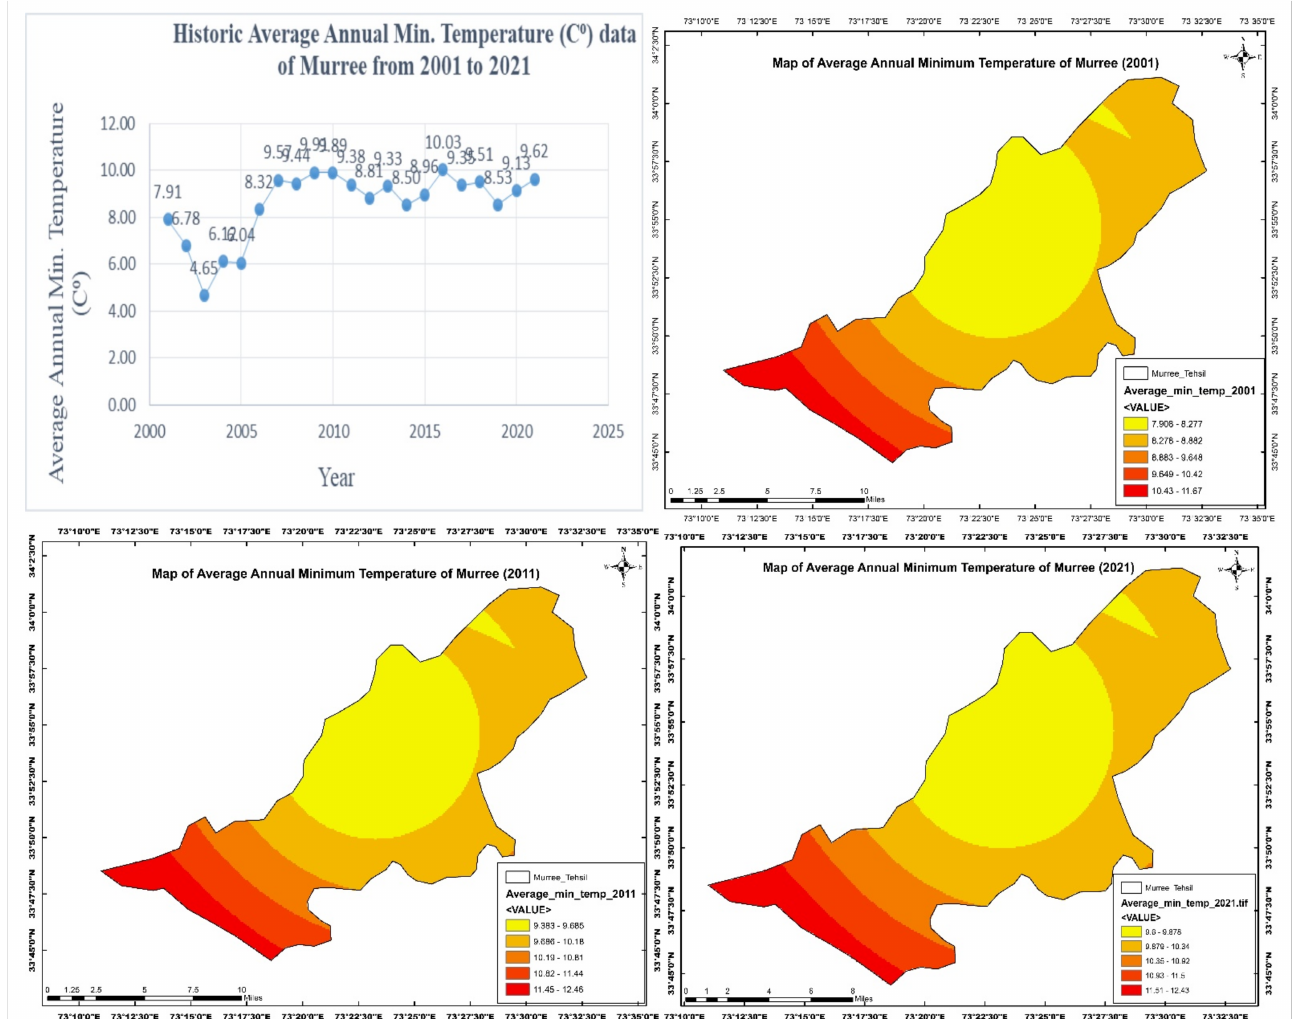
Figure 5. Average annual minimum temperature ( ◦ C) data and temperature distribution of Murree (from